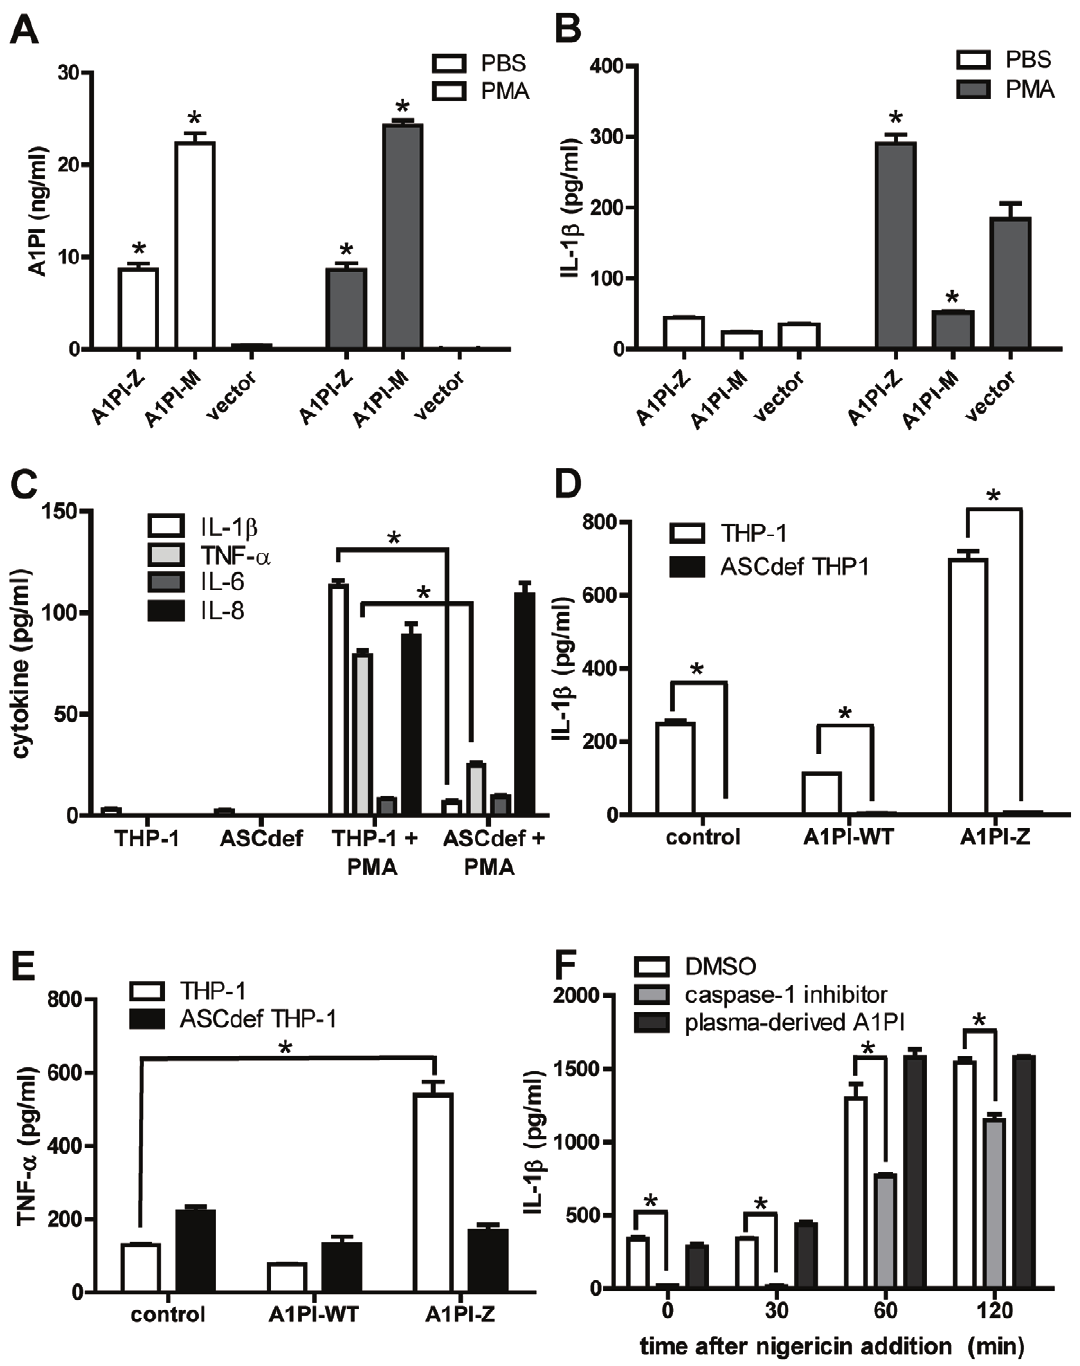
Figure 3. A1PI Impacts ASC Dependent IL-1 b Release in Transfected Monocytes. A-B) THP-1 cells were nucleofected with plasmids encoding wild type A1PI (A1PI-M) or Z isoform A1PI (A1PI-Z). Cells were stimulated with PMA or PBS control for 5 days, and A1PI (A) and IL-1 b (B) were detected in supernatant by ELISA. C) Secreted IL-6, IL-8, TNF- a and IL-1 b were detected in supernatants of THP-1 cells or THP-1 cells lacking ASC, incubated with PMA or PBS control for 5 days. D-E) THP-1 cells or THP-1 cells lacking ASC were nucleofected with vectors expressing A1PI-M or A1PI-Z, then challenged with PMA. Secreted IL-1 b (D) and TNF- a (E) were detected in supernatants collected on day 5. F) THP-1 cells stably expressing A1PI-Z were pre-treated with caspase-1 inhibitor (40 m M) or plasma-derived A1PI (1 mg/ml), then PMA stimulated for 18 hours followed by 20 m M nigericin challenge. Secreted IL-1 b was measured in supernatants collected up to 120 minutes post nigericin. Asterisks denote P # 0.05.